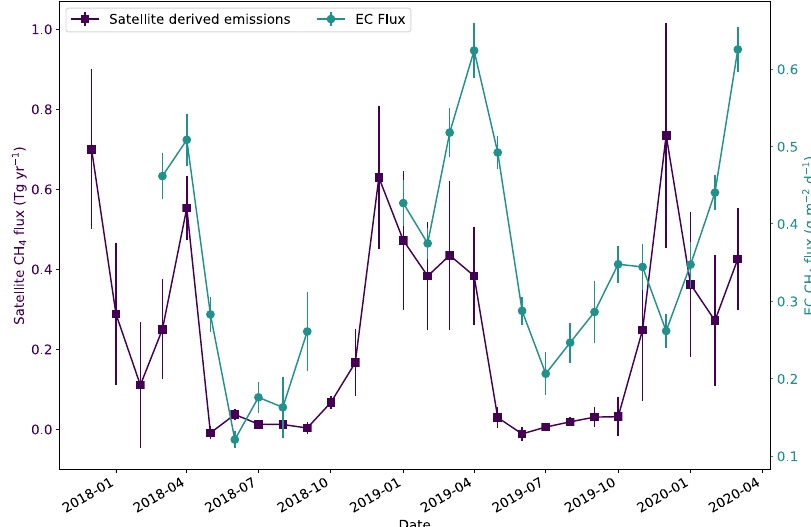
Fig. 3 Local and delta-scale methane emission estimates. Monthly emission estimates of CH 4 net fl uxes (g m − 2 d − 1 ) from eddy-covariance (EC) measurements (round symbols) over Cyperus papyrus at Guma Lagoon (18°57 ′ 53.01 ″ S; 22°22 ′ 16.20 ″ E), in the permanently fl ooded part of the Okavango Delta, and inferred from satellite observations of column CH 4 over the entire Okavango Delta (Tg yr − 1 ; square symbols). Data are presented as mean values ±2 standard deviations from the mean. The monthly EC budgets were constructed by summing diel cycles of hourly means; total uncertainty was obtained by propagating hourly standard deviation of the mean in quadrature ( n = 24 independent hourly data points, see Eq. (1)). Due to the stochastic nature of the inversions used to derive emission estimates from satellite information, it is not possible to report a deterministic number of samples.